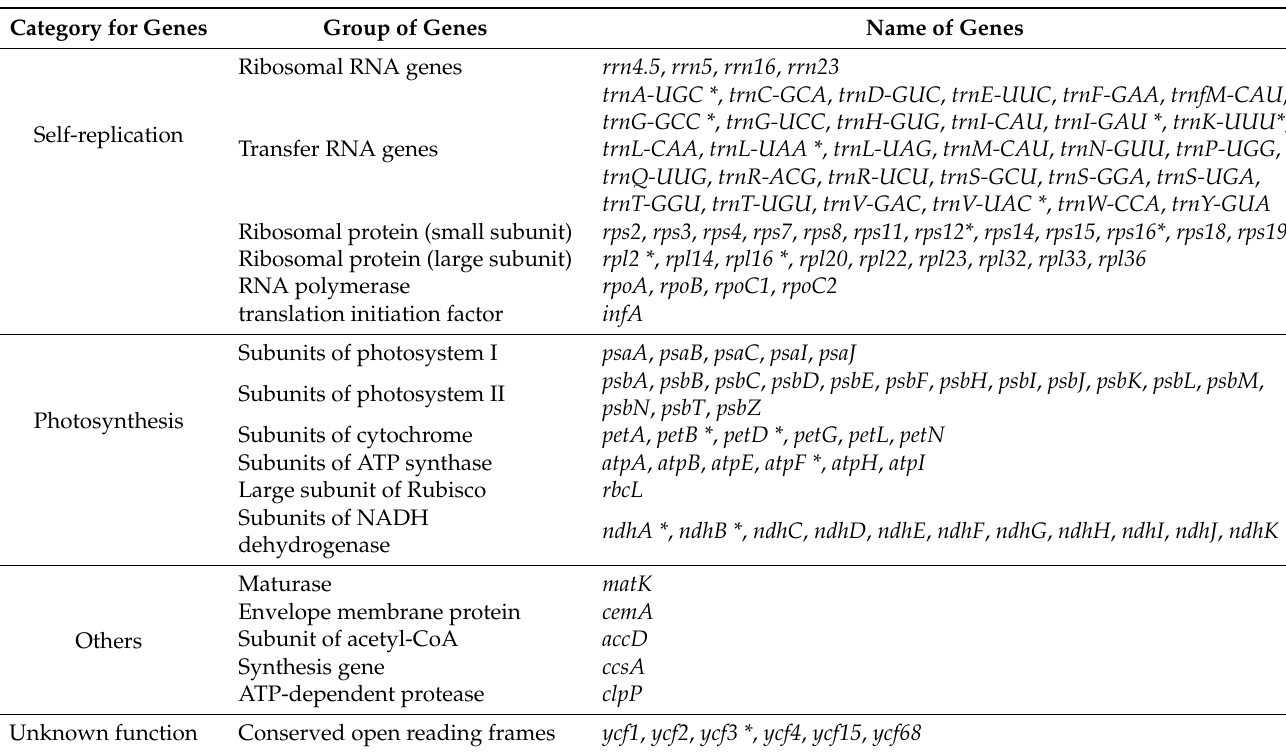
Table 2. List of the annotated genes in the chloroplast genomes of seven ornamental bamboo species. Category for Genes